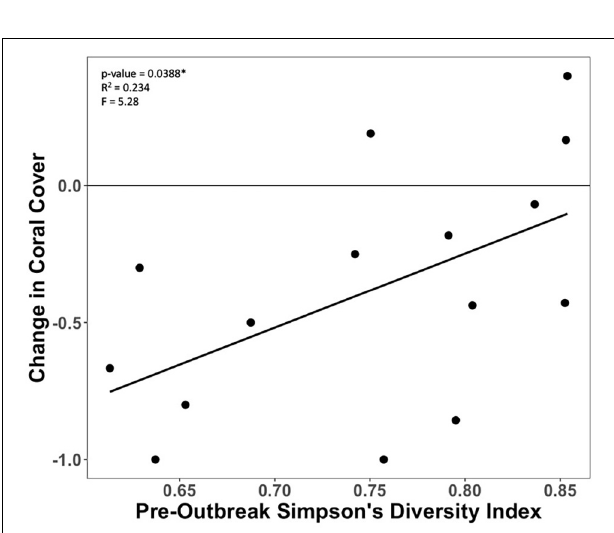
FIGURE 6 | Relationship between proportional change in coral cover and pre-outbreak Simpson’s Diversity Index in the endemic zone.